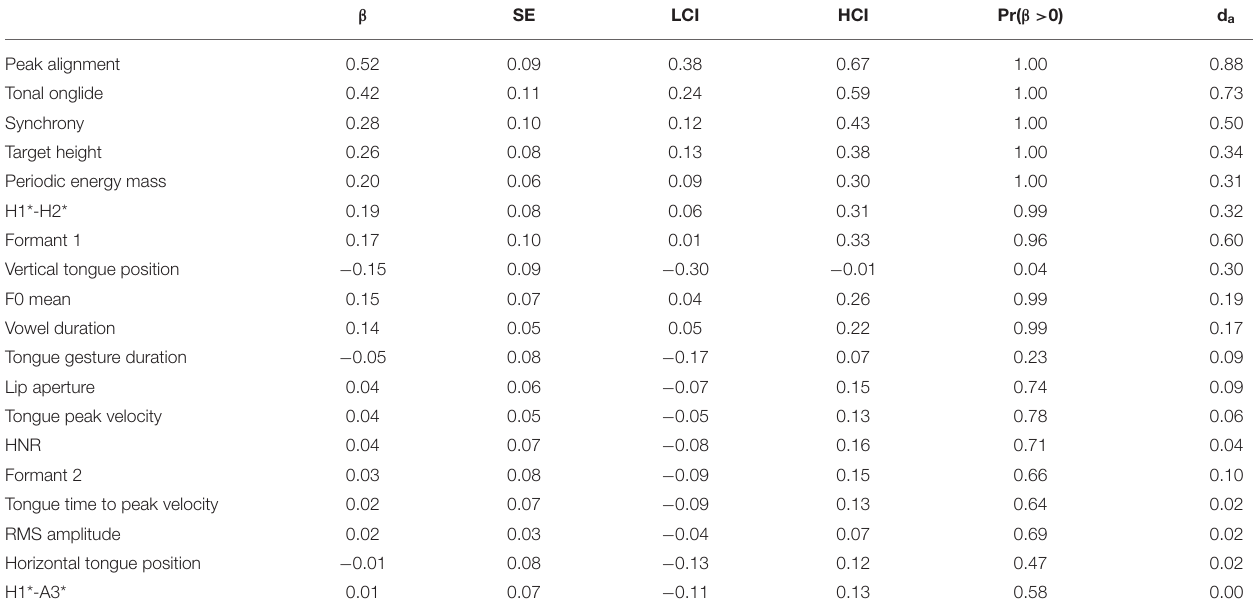
TABLE 7 | Tabular overview of modeling results for broad vs. narrow focus, vowel /a/. LCI and HCI refer to the low and high boundaries of the 90% Credible